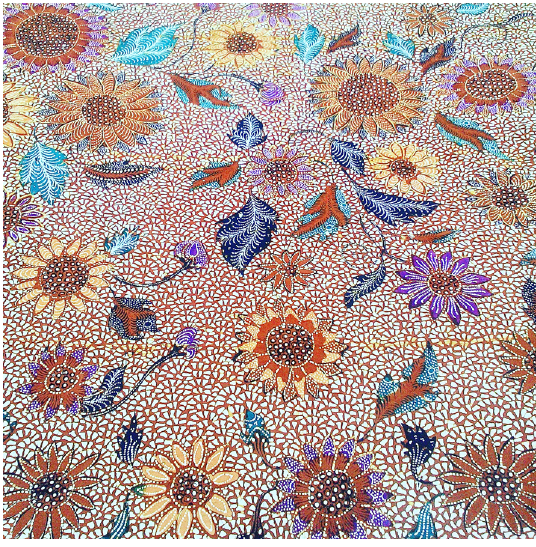
Supplementary images: Anto's paints . Not included in the